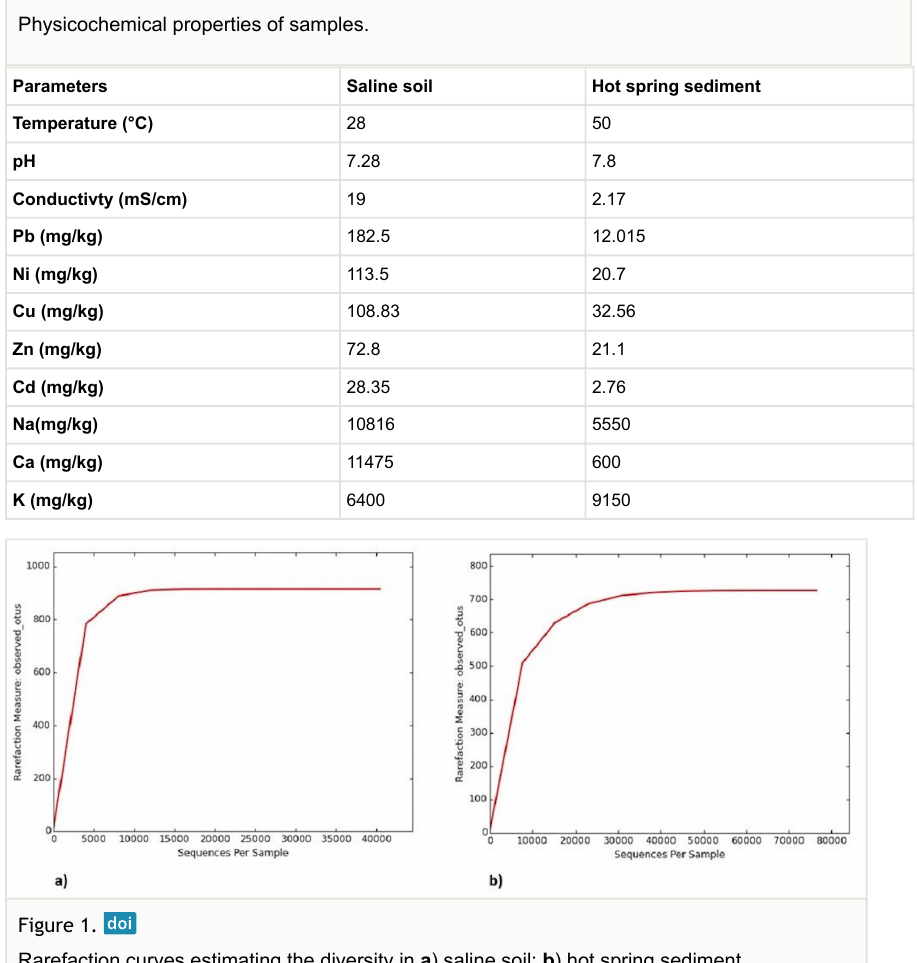
Rarefaction curves estimating the diversity in a ) saline soil; b ) hot spring In the saline sample, a total of 35 distinct prokaryotic phyla were detected by metagenomic analysis, out of which Proteobacteria account for 46.20% of the total biodiversity. Amongst Proteobacteria , Gammaproteobacteria was the most prevalent class of bacteria. Deltaproteobacteria was comparatively less abundant. Alphaproteobacteria and Betaproteobacteria were poorly represented. Euryarchaeota was the second most